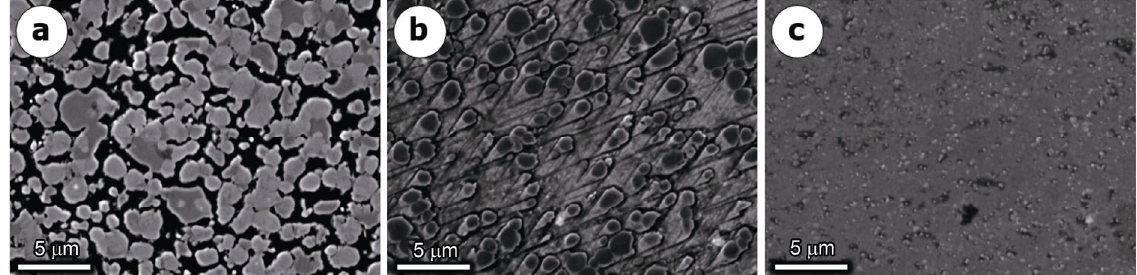
Fig. 12 SEM micrographs of the unworn mirror-polished (a) tool steel A, (b) tool steel V, and (c) tool steel O pin samples at 5,000× magnification, showing the different carbides revealed after the polishing